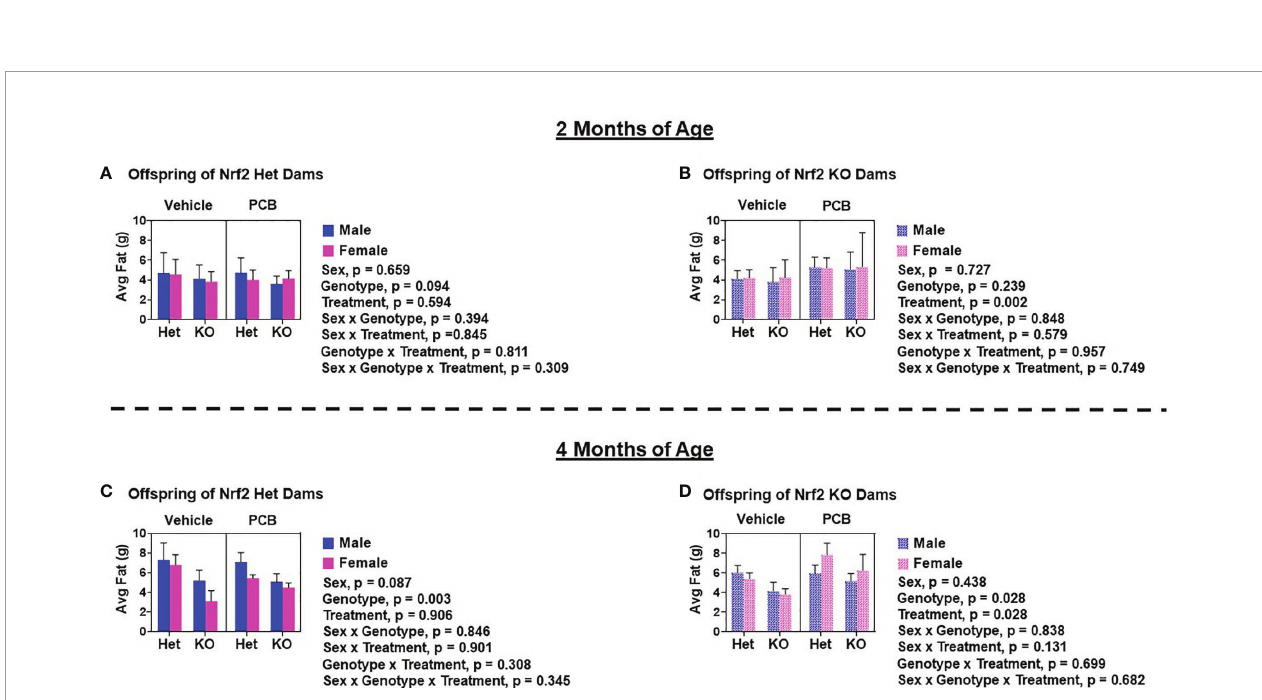
FIGURE 4 | Adult offspring born to Nrf2 knockout dams exhibit signi fi cant elevations in fat deposition as a result of gestational PCB126 exposure. Shown are the fat mass measurements of offspring born to Nrf2 heterozygous (A, C) or knockout (B, D) dams at two and four months of age. Data were obtained using EchoMRI and the values shown are indicative of the mean of litter means (n = 8 – 13 per group) ± SEM. Offspring fat mass data were analyzed using three-factor ANOVA. Signi fi cance was set at a =